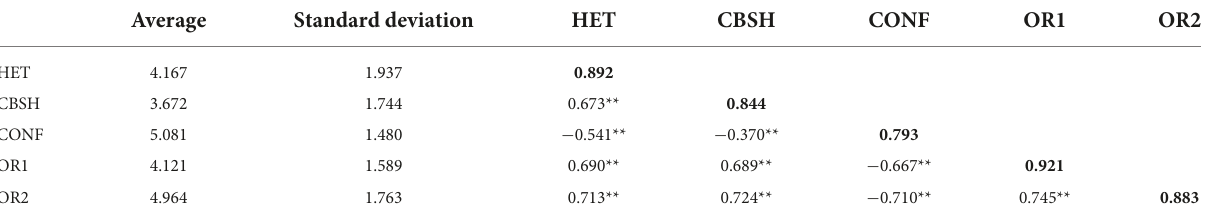
TABLE 3 Correlation